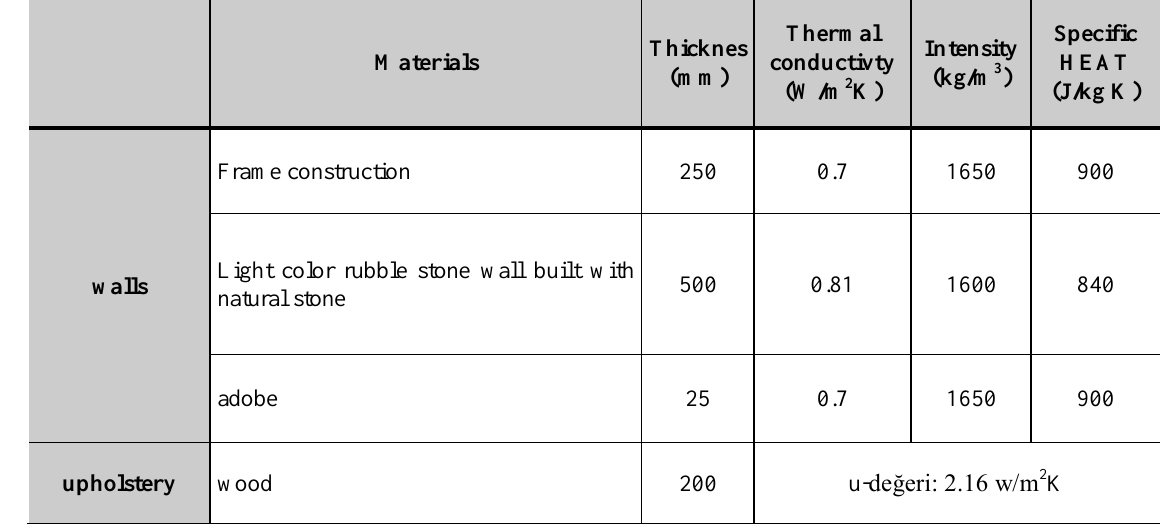
Table 3. Materials and account values for thermal analysis – Nihal